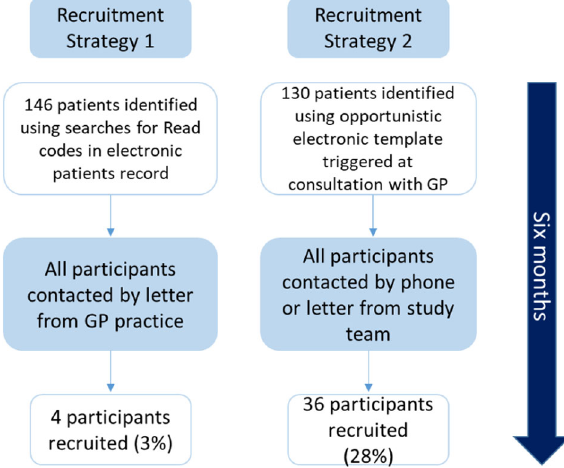
Fig. 2 Recruitment fl ow diagram. A comparison of recruitment numbers between Strategy 1 and 2 over six